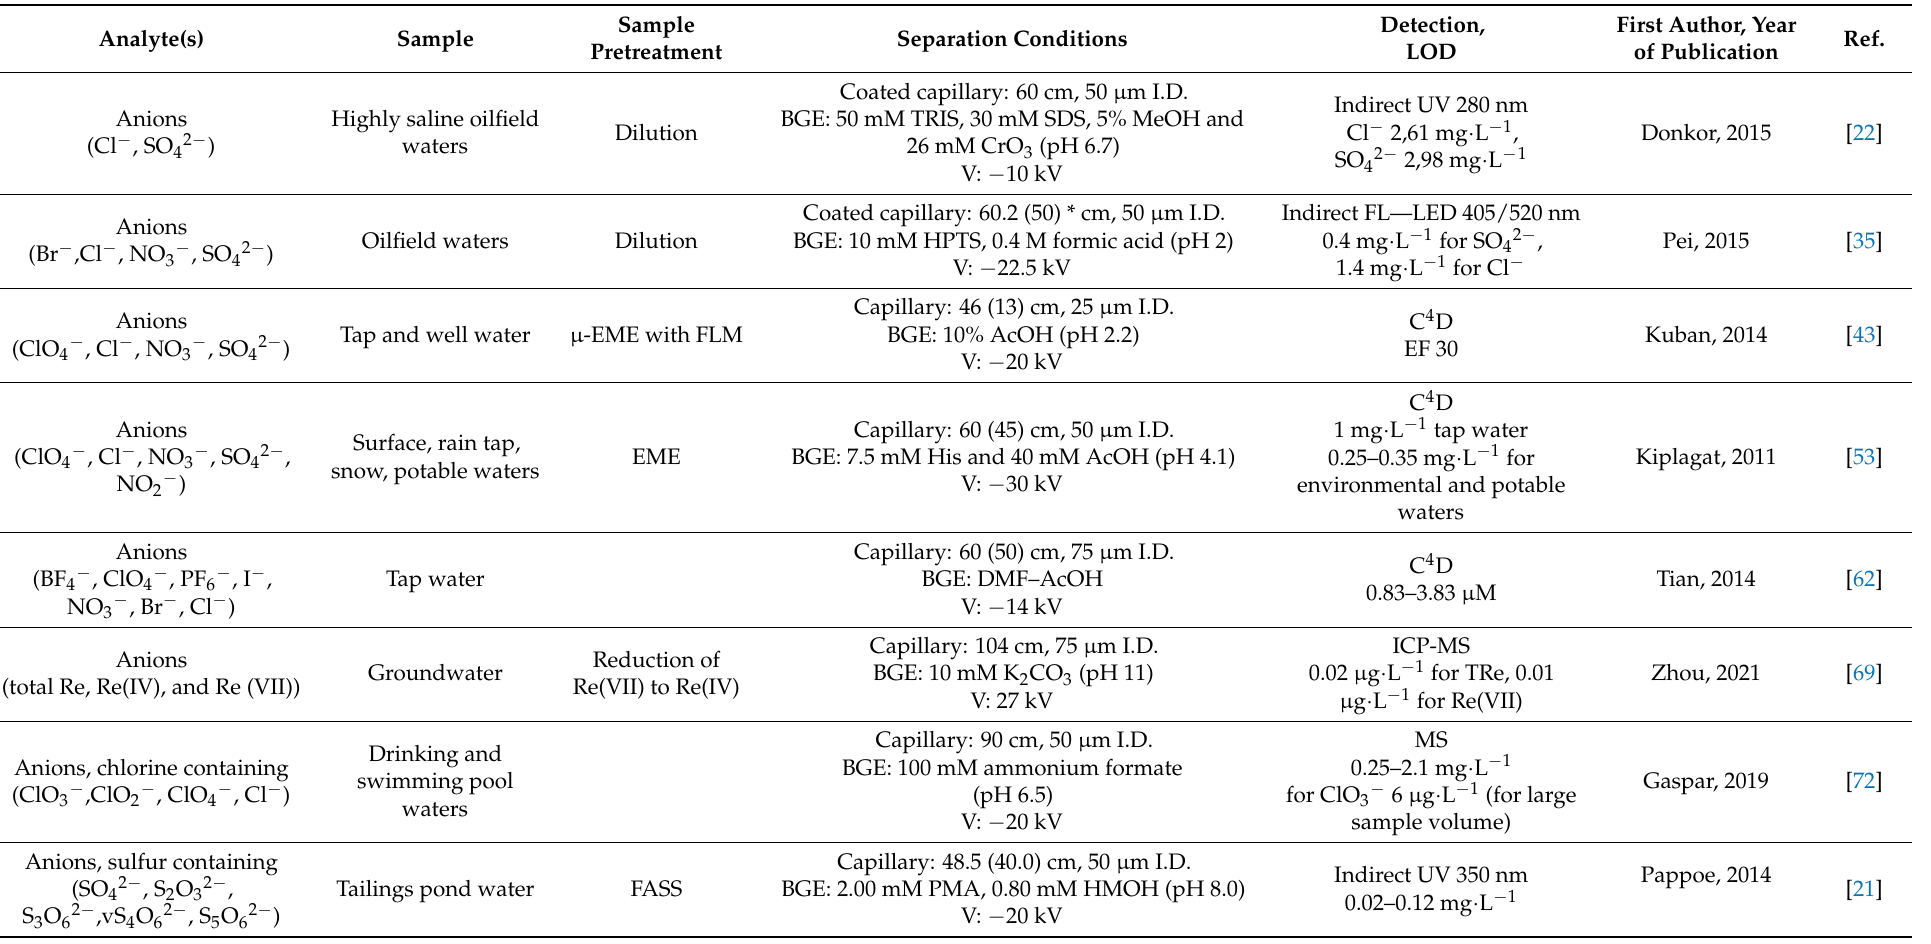
Table 1. Applications of capillary electrophoresis methods with various detections in water